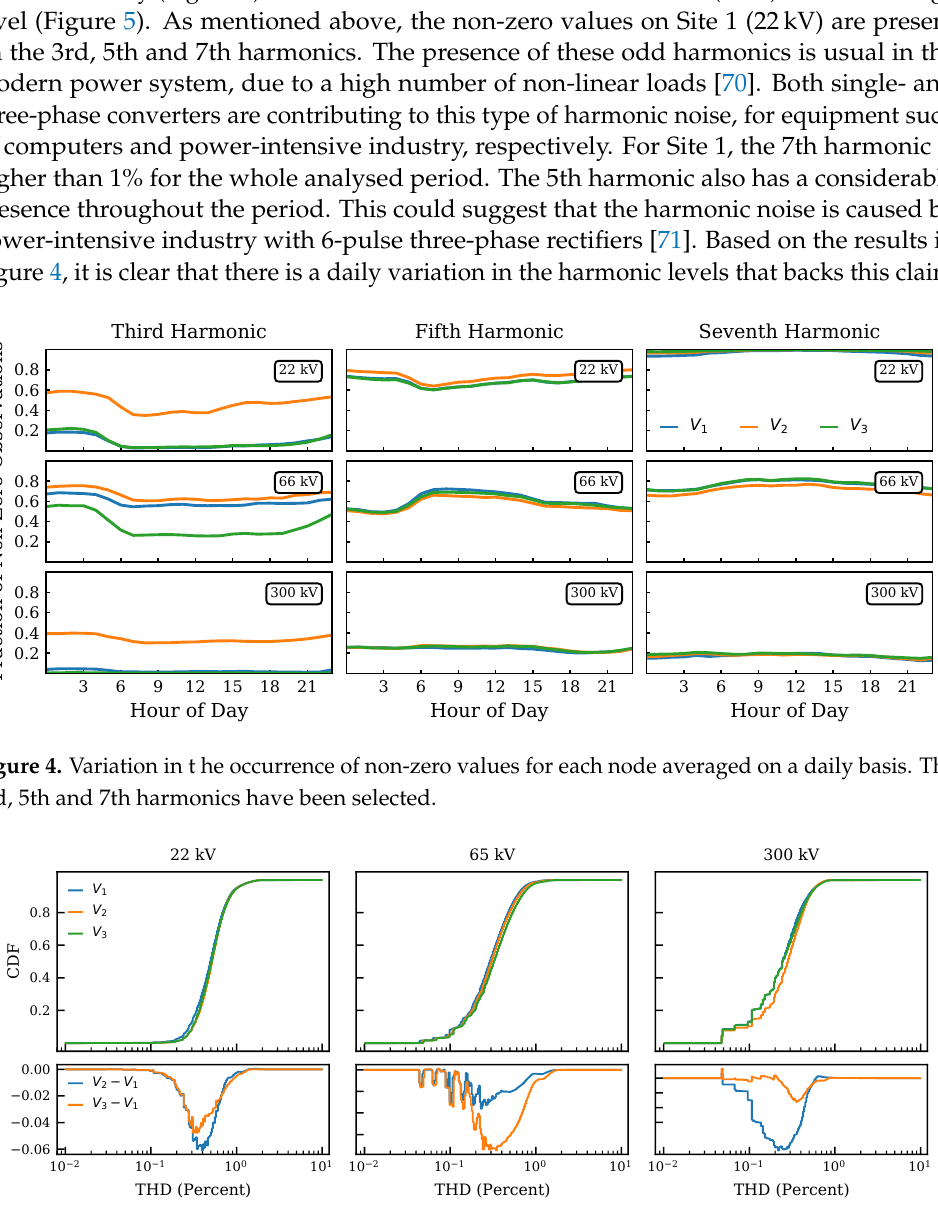
Figure 5. Cumulative distribution function (CDF) of total harmonic distortion (THD) for three sites (columns). We use 256 bins of uniform logarithmic spacing from 10 − 2 to 10. Distributions are calculated over the time range from 2015 to 2018 for a total of ∼ 5.9 × 10 9 samples. Top : CDFs for each phase (see legend). Bottom : Difference between the CDFs for V 2 and V 1 as well as V 3 and V 1 , respectively (see legend). Statistically, the three phases always remain within six percent of each other. See Table 2 for summary